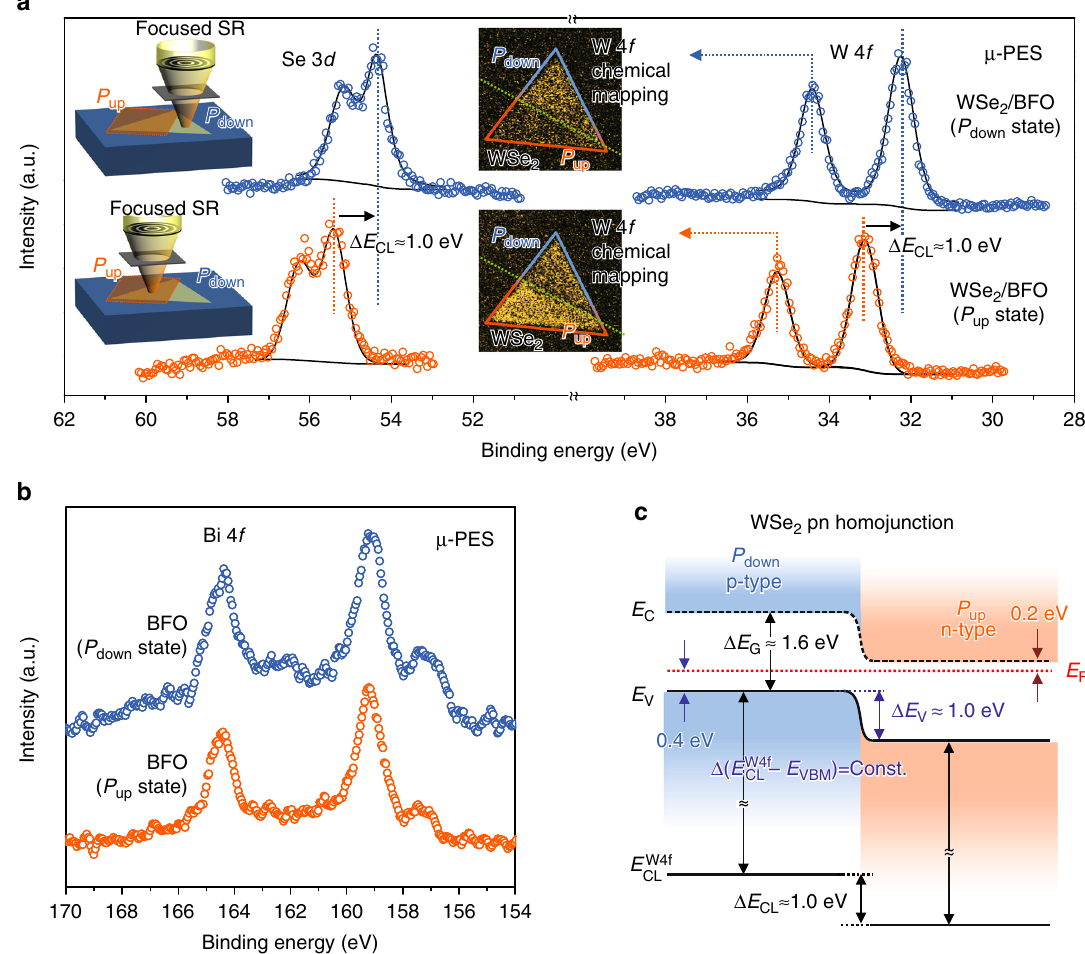
Fig. 3 SPEM images and μ -PES measurements on the WSe 2 pn homojunction. Se 3 d , W 4 f , and Bi 4 f core-level photoelectron spectra measured with SPEM in P up and P down regions of a WSe 2 /BFO homojunction. a Core-level spectra of Se 3 d and W 4 f recorded from a P down (blue) and a P up (orange) region. SPEM images of W 4 f taken in 34.6 eV and 35.4 eV, which correspond to a P down and a P up region, respectively. b Core-level spectra of Bi 4 f emitted from the BFO substrate. c The band structure deduced from a reveals the pn junction for WSe 2 in P down and P up regions near 300